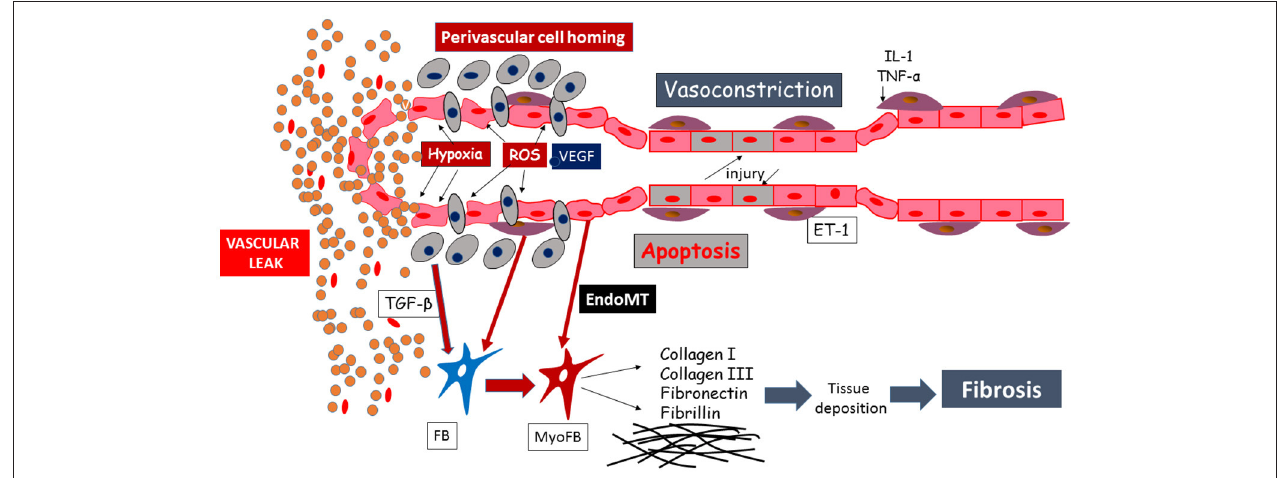
FIGURE 2 | Schematic representation of the mechanisms leading to endothelial injury and capillary sufferance, evolving into vascular